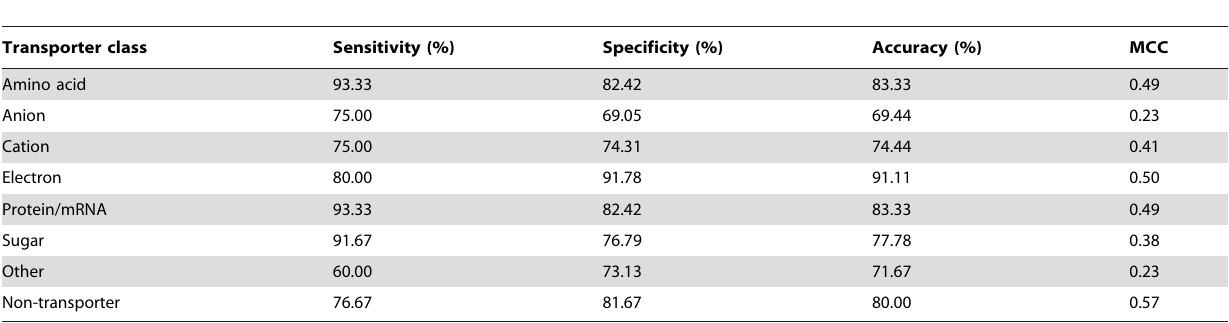
Table 3. The performances of the best models on the independent dataset for different substrate-specific transporter classes.